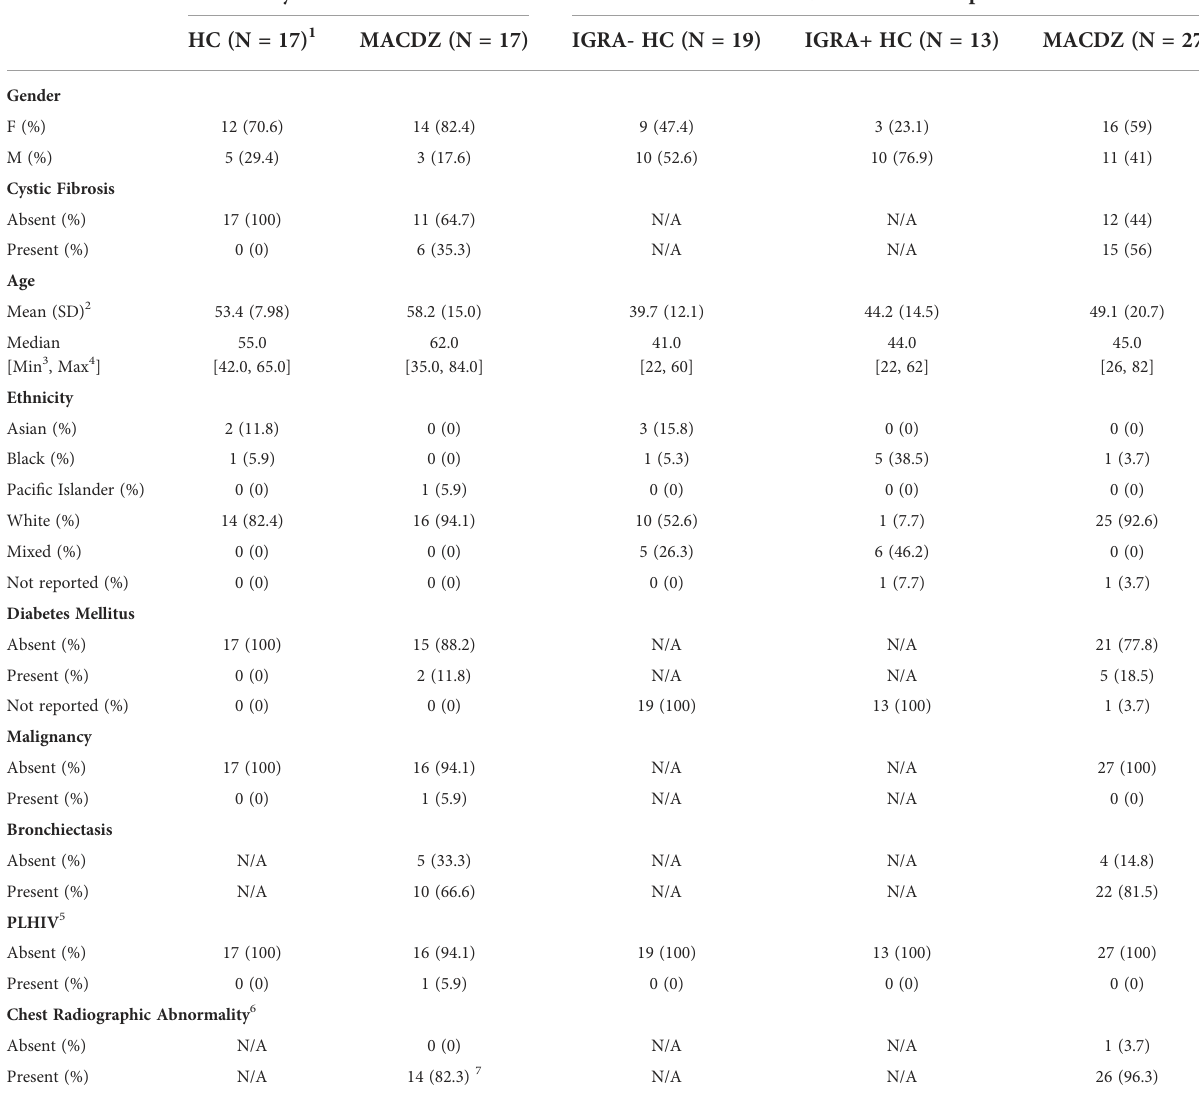
TABLE 1 Demographic and clinical characteristics of